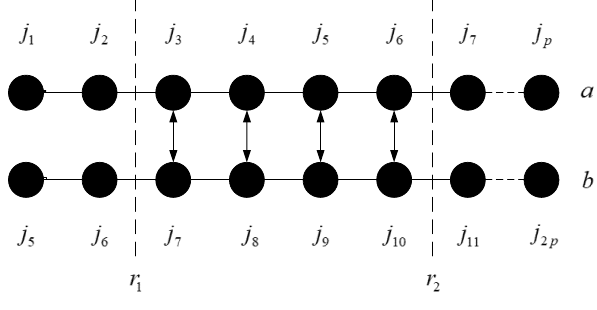
Figure 2. Crossover process.